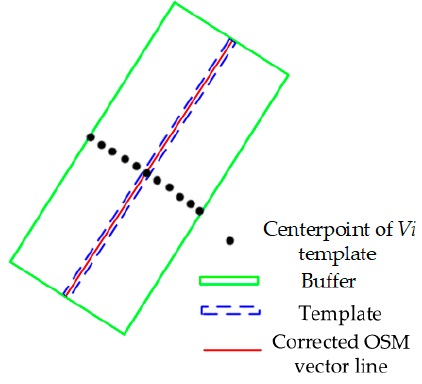
Figure 3. Road homogeneity constraint.